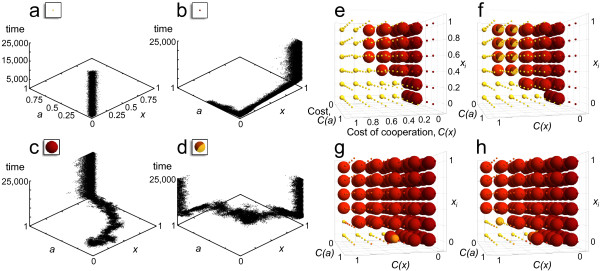
Simulation results for the multilevel selection model with voluntary participation. The average propensity for cooperation concerning the two kinds of group actions, the public goods game and the voluntary group competition action as a function of the two costs of cooperation (C(x) and C(a)) and the initial ratio of cooperators (xi) in the Public Goods Game. (a) For high cost values the tendency of cooperating in both of group actions is low, (b) or there is a full cooperation in the Public Goods Game, but full defection in the group defense action. (c) If the costs of cooperation are not high, every individual cooperates in both of the group actions (x = ~1, a = ~1). (d) At the boundaries of these regions, for intermediate cost values division of labour evolves in the population (h). On graphs e.-h. each bubble illustrates the results of an individual based simulation, the size representing the average a in the population (large bubbles represent a = 1 and vice versa), and the colouring depicting the average value of x (red bubbles denote x = 1, while yellow ones denote x = 0). For the simulations we either used no initial incentive in the populations for participating in the group competition (ai = 0) (e, g), or the simulation was started with full participation (ai = 1) (f, h). The 5 group members were either picked randomly from the population in the well-mixed model (e, f), or from the same site in the spatially explicit model (g, h). ((a) C(x) = 0.5, C(a) = 0.5, xi = 0, ai = 0; (b) C(x) = 0, C(a) = 0.6, xi = 0, ai = 0.5; (c) C(x) = 0.2, C(a) = 0.05, xi = 0.05, ai = 0.2; (d) C(x) = 0.6, C(a) = 0.2, xi = 0.6, ai = 0.5).